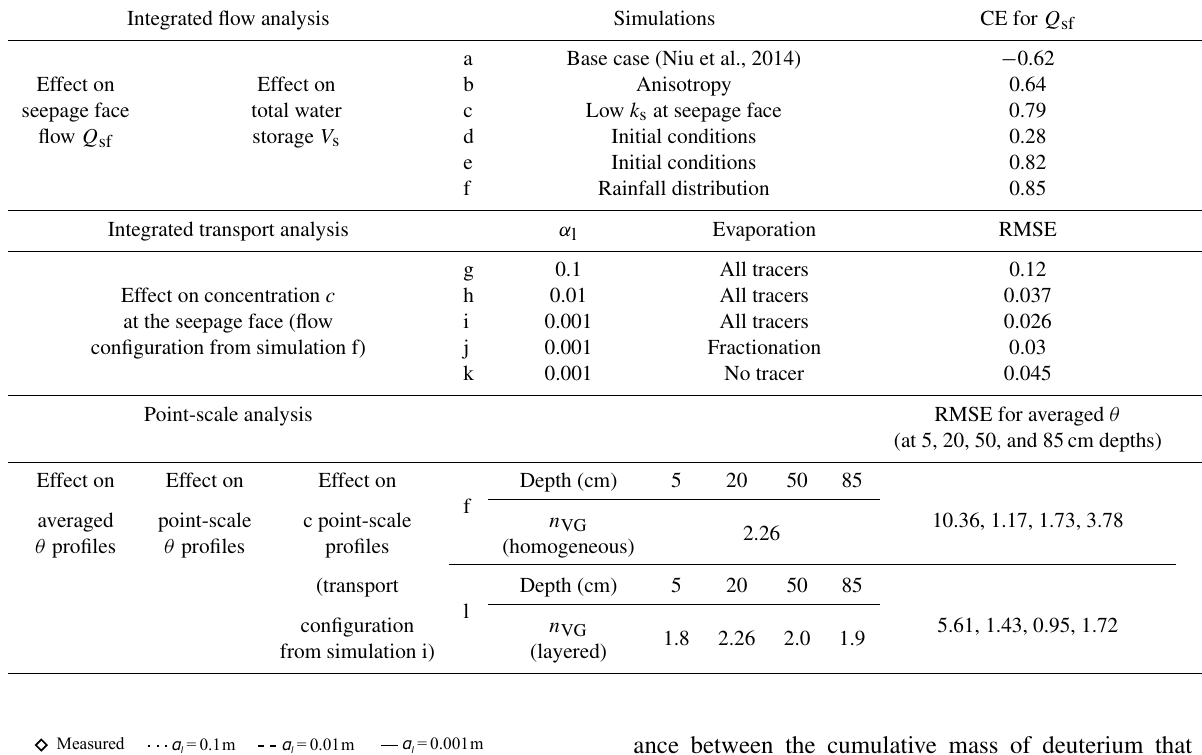
Table 3. Simulation descriptions, parameter configurations, and performance metrics (coefficient of efficiency CE and root mean squared error RMSE) for the integrated flow, integrated transport, and point-scale analysis steps.